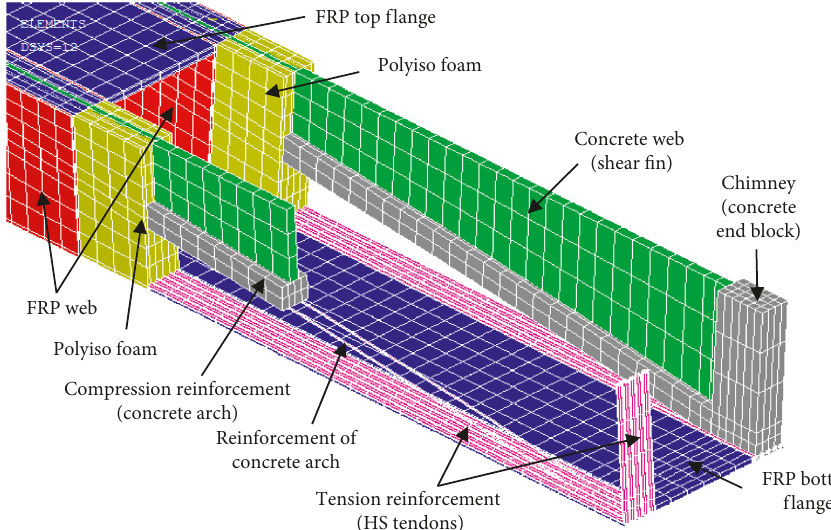
Figure 4: Finite element modeling of multicelled hybrid composite beam using ANSYS